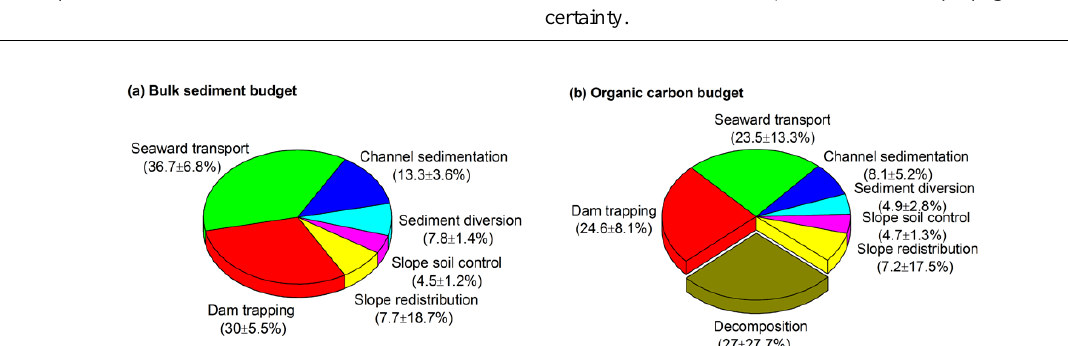
Fig. 6. Pie charts summarizing the redistribution of the bulk sediment (a) and organic carbon (b) , based on the erosion rate of 2.2Gtyr − 1 with 1.7–2.5Gtyr − 1 for the consideration of